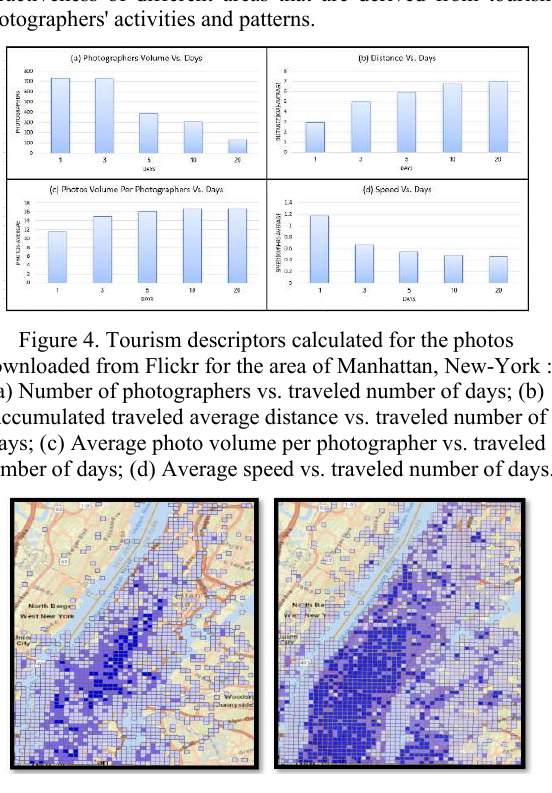
Figure 5. Heat map comparison of Flickr photos in Manhattan (based on Natural Jenks classification): tourism photographers based (left) and photo-based (right): bright blue - lower values, dark blue - higher values (background: